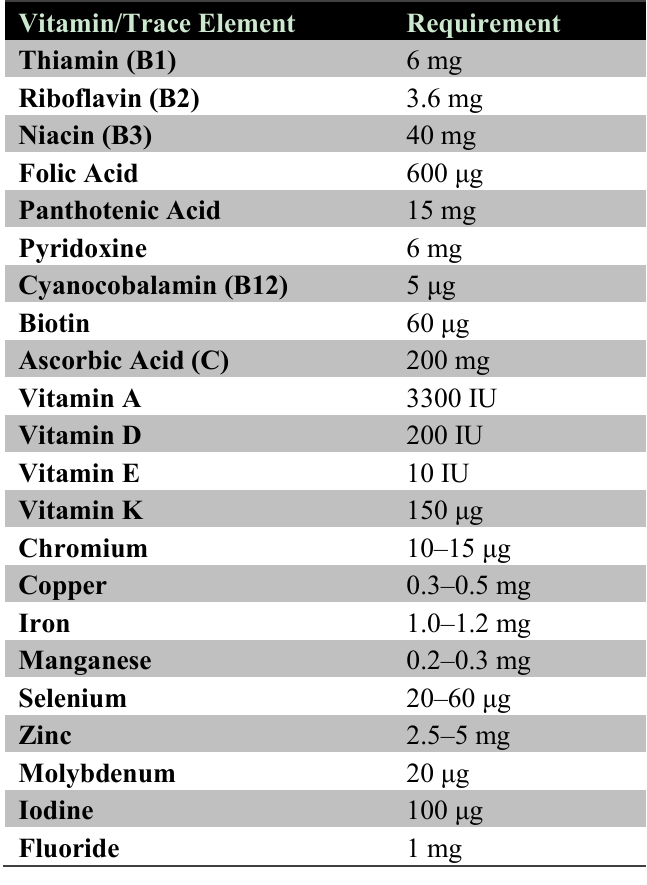
Table 2. The daily vitamin and trace element requirements for an adult receiving artificial nutrition. Note: This table is reproduced with permission from [20], Copyright © 2009 European Society for Clinical Nutrition and